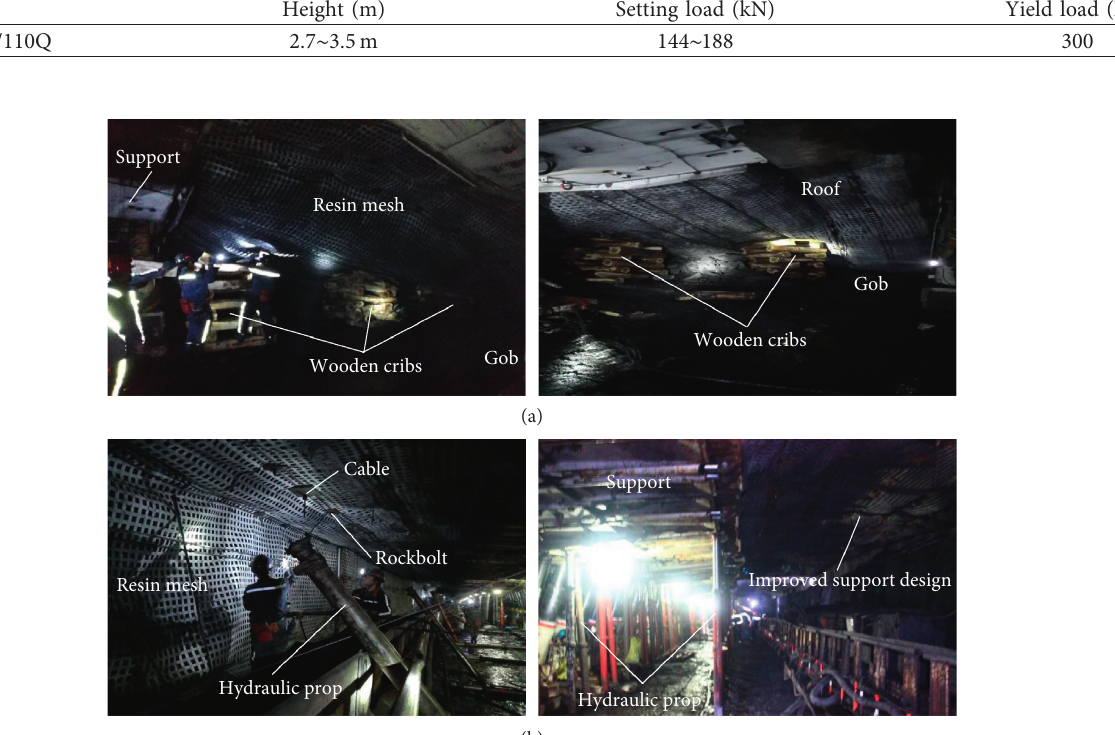
Figure 23: Construction sites of the recovery roadways: (a) #3-1 coal seam in the Liangshuijing coal mine; (b) #4 coal seam in the Fengjiata coal